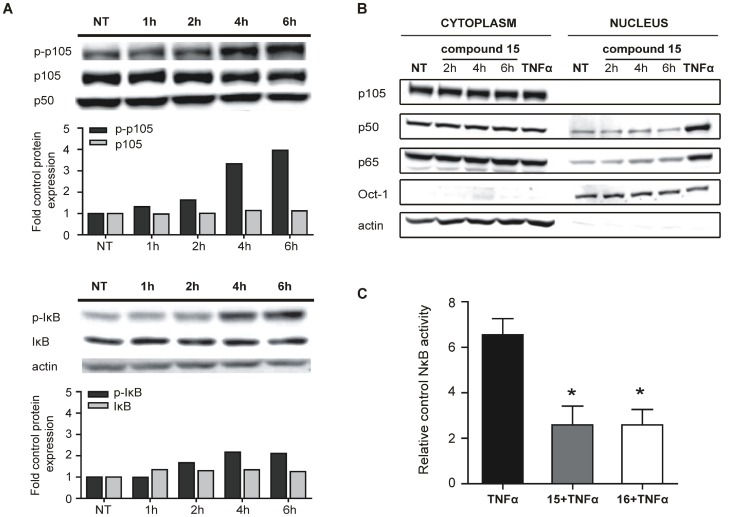
Accumulation of phospho-IκB and phospho-p105 with no subsequent increase in NFκB transcriptional activity.(A) Western blot analysis of Ramos cell lysates after treatment with compound 15 for the indicated time periods. Phospho-p105, p105, phospho-IκB and IκB were determined; with p50 or actin being used as loading controls. The relative quantifications of protein expression compared to control are graphically presented below each western blot. (B) Western blot analysis of cytoplasm and nuclear protein fractions after treating cells for indicated lengths of time with inhibitor 15 or TNFα (100 ng/mL, 6 h, the latter used as a positive control. (C) The determination of NFκB transcriptional activity. SEAP activity was measured in Ramos-Blue™ cells after pre-treating them for 1 h with compounds 15 or 16 (50 µM) and subsequently adding TNFα (100 ng/mL). After 8 h, the supernatant was collected and SEAP activity was determined. Results present 3 independent experiments. * P<0.05; NT, non-treated cells.